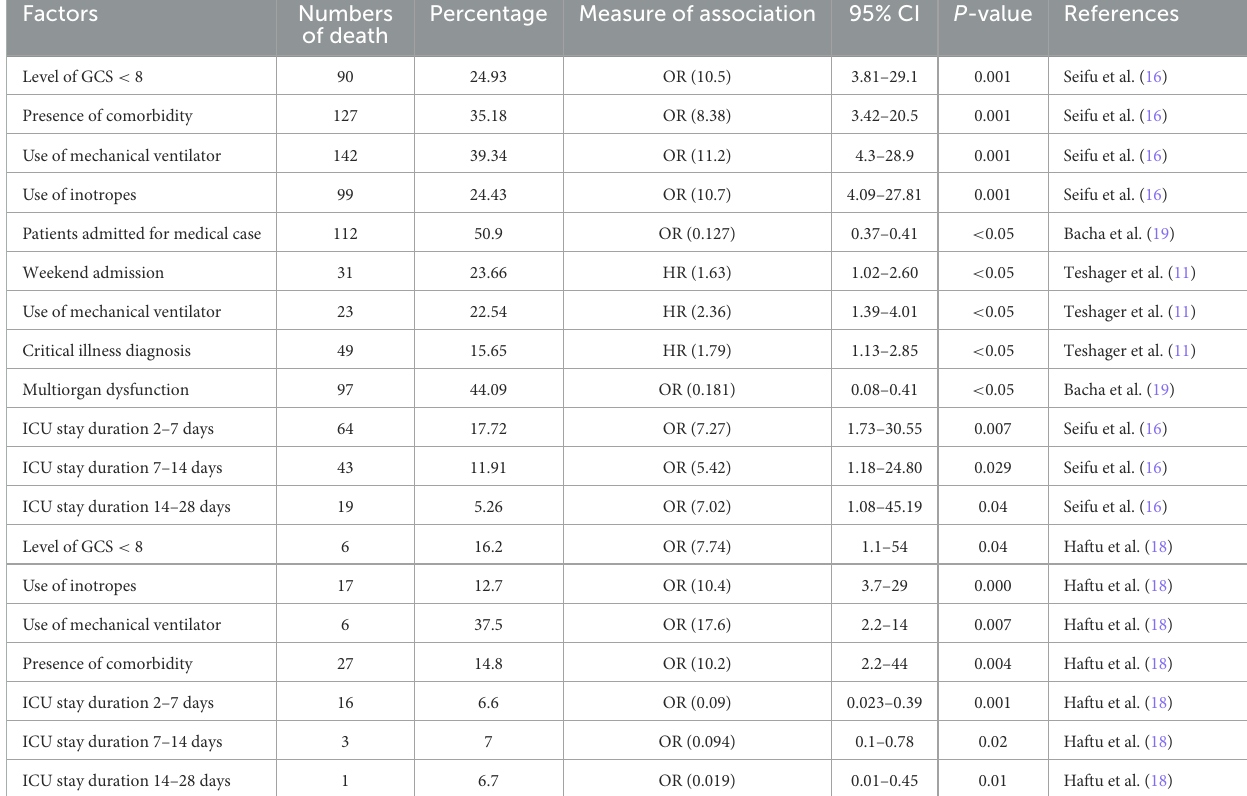
TABLE 2 Characteristics of determinant factors of pediatric mortality in a pediatric intensive care unit,